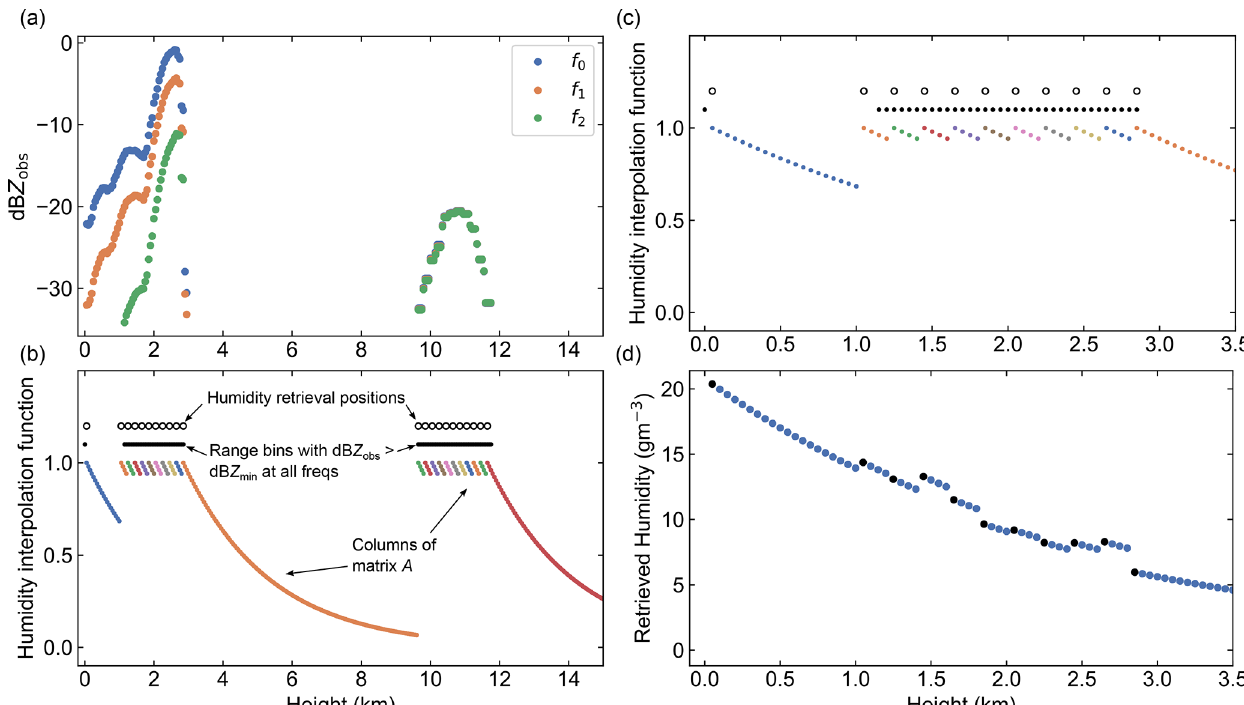
Figure C1. Humidity interpolation procedure for the DAR retrieval, using an example from the GATE case. (a) Vertical profiles of observed reflectivity at the three DAR frequencies for the y = 100km position in Fig. 2c. In this case, the surface NRCS (not shown) is above the sensitivity threshold for all three frequencies. (b) Graphical depiction of the procedure for determining the projected measurement axis ( r = P r r (cid:48) – solid black circles) and humidity retrieval axis ( z = P z z (cid:48) – open black circles), as well as the humidity interpolation functions, which are the columns of the matrix A (differently colored, partial exponential profiles). (c) Close-up of panel (b) for clarity. (d) Resulting retrieved humidity profile (uncertainty not shown), including the N retrieved humidity elements of the state vector ( x 2 – black circles) and the corresponding interpolated humidity profile A x 2 (blue